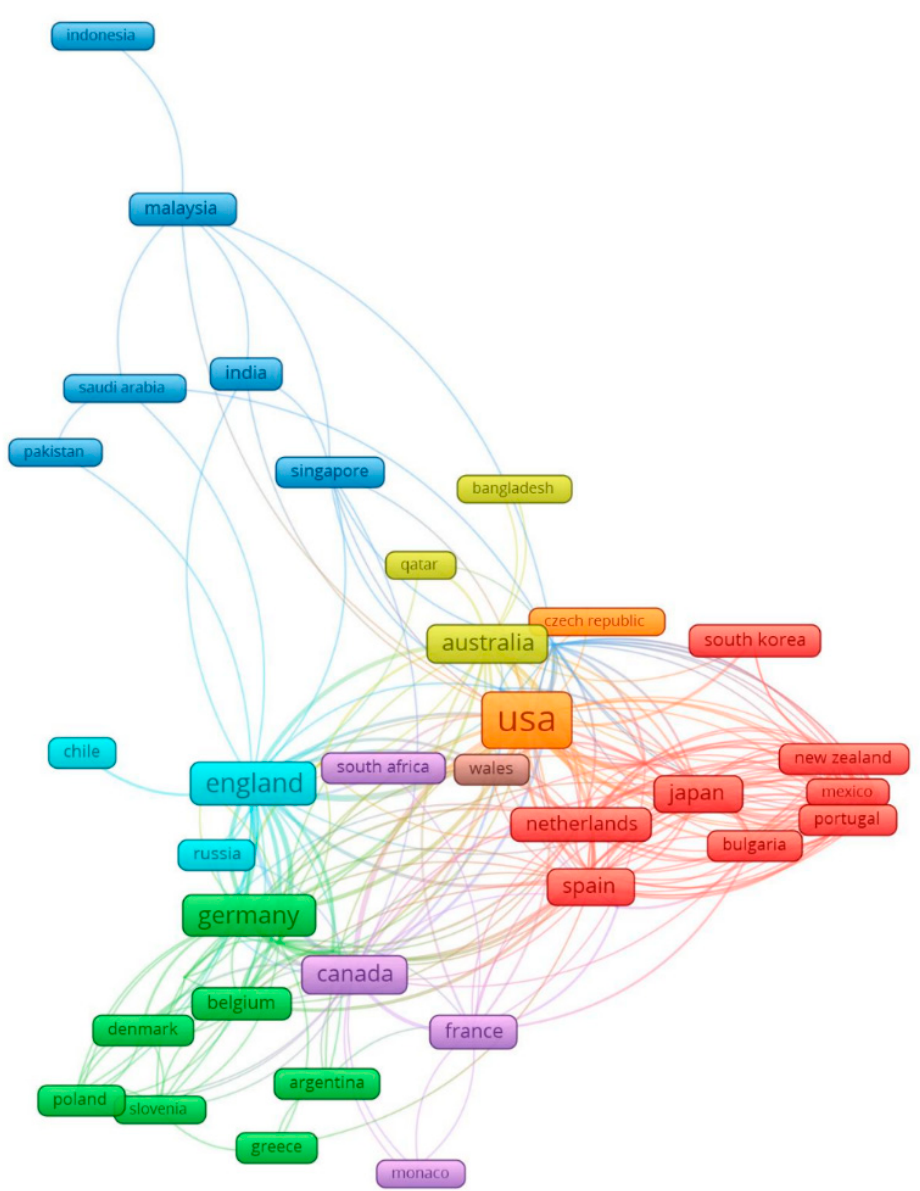
Figure 1. The global networking of 55 countries having at least five co-authorships are classified in six clusters.